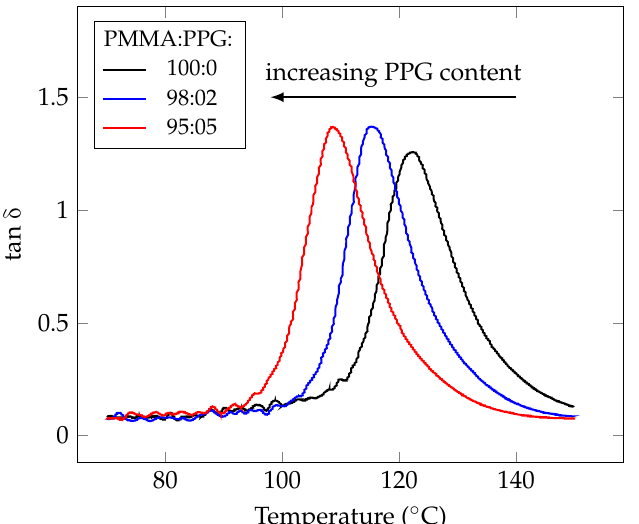
Figure 2. Dynamic mechanical thermal analysis of methyl methacrylate, polymerized in the presence of various content of poly(propylene glycol) ( M n 446), showing the loss tangent as a function of tem- perature, is consistent with plasticization theory, wherein increasing plasticizer content corresponds to decreasing glass transition temperature of the resulting material.